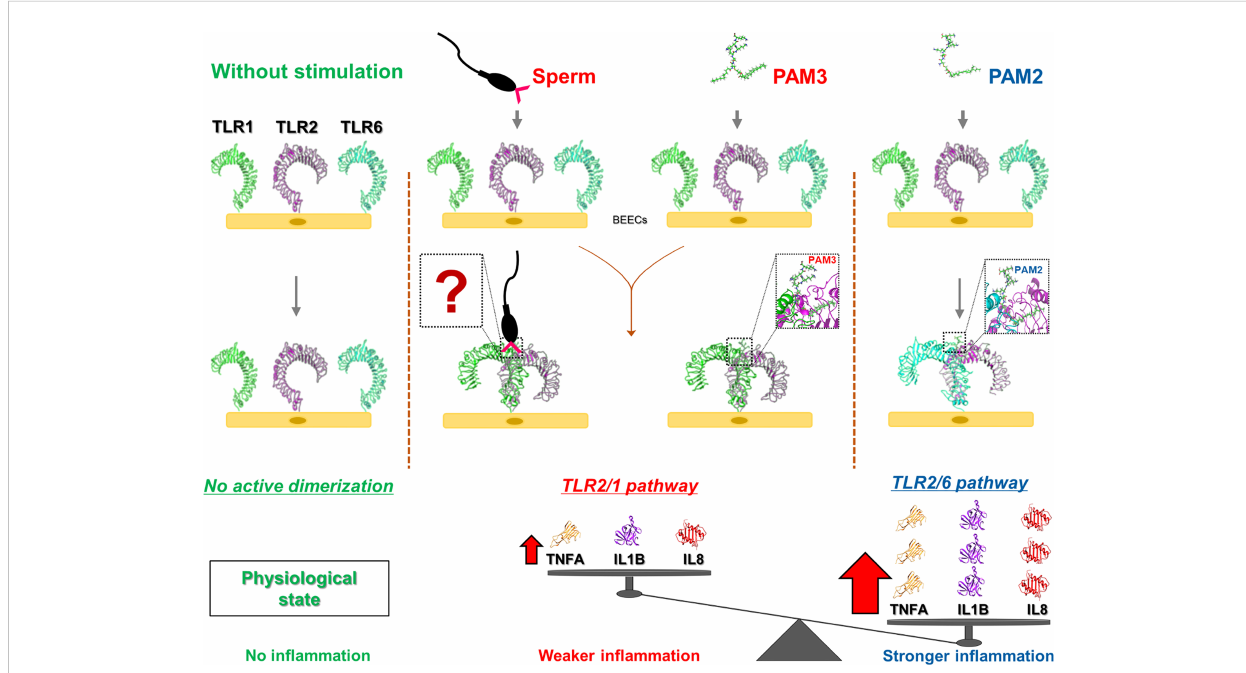
FIGURE 7 A graphic demo of our working hypothesis on the activation of possible TLR2 pathway signaling in sperm-induced in fl ammation in bovine endometrial epithelia. The model demonstrating that the stimulation of endometrial epithelia with different TLR2 agonist (PAM3: TLR2/1 and PAM2: TLR2/6) results in different intensity in in fl ammation response. In fact, initiating TLR2/1 signaling cascade could lead to weaker in fl ammation compared to TLR2/6. As for sperm-endometrial epithelial interaction, sperm induce TLR2/1 heterodimerization signaling, to trigger the weak and acute in fl ammation. We suppose that sperm may use small molecules from its surface (such as lipopeptides or glycans) to enhance TLR2/1 dimerization. However, further investigations are required to de fi ne the speci fi c ligand(s) on the sperm cell membrane that regulate the initiation of TLR2/1 heterodimerization. “ ? ” shows the unknown molecules form sperm surface side which may link TLR1 to